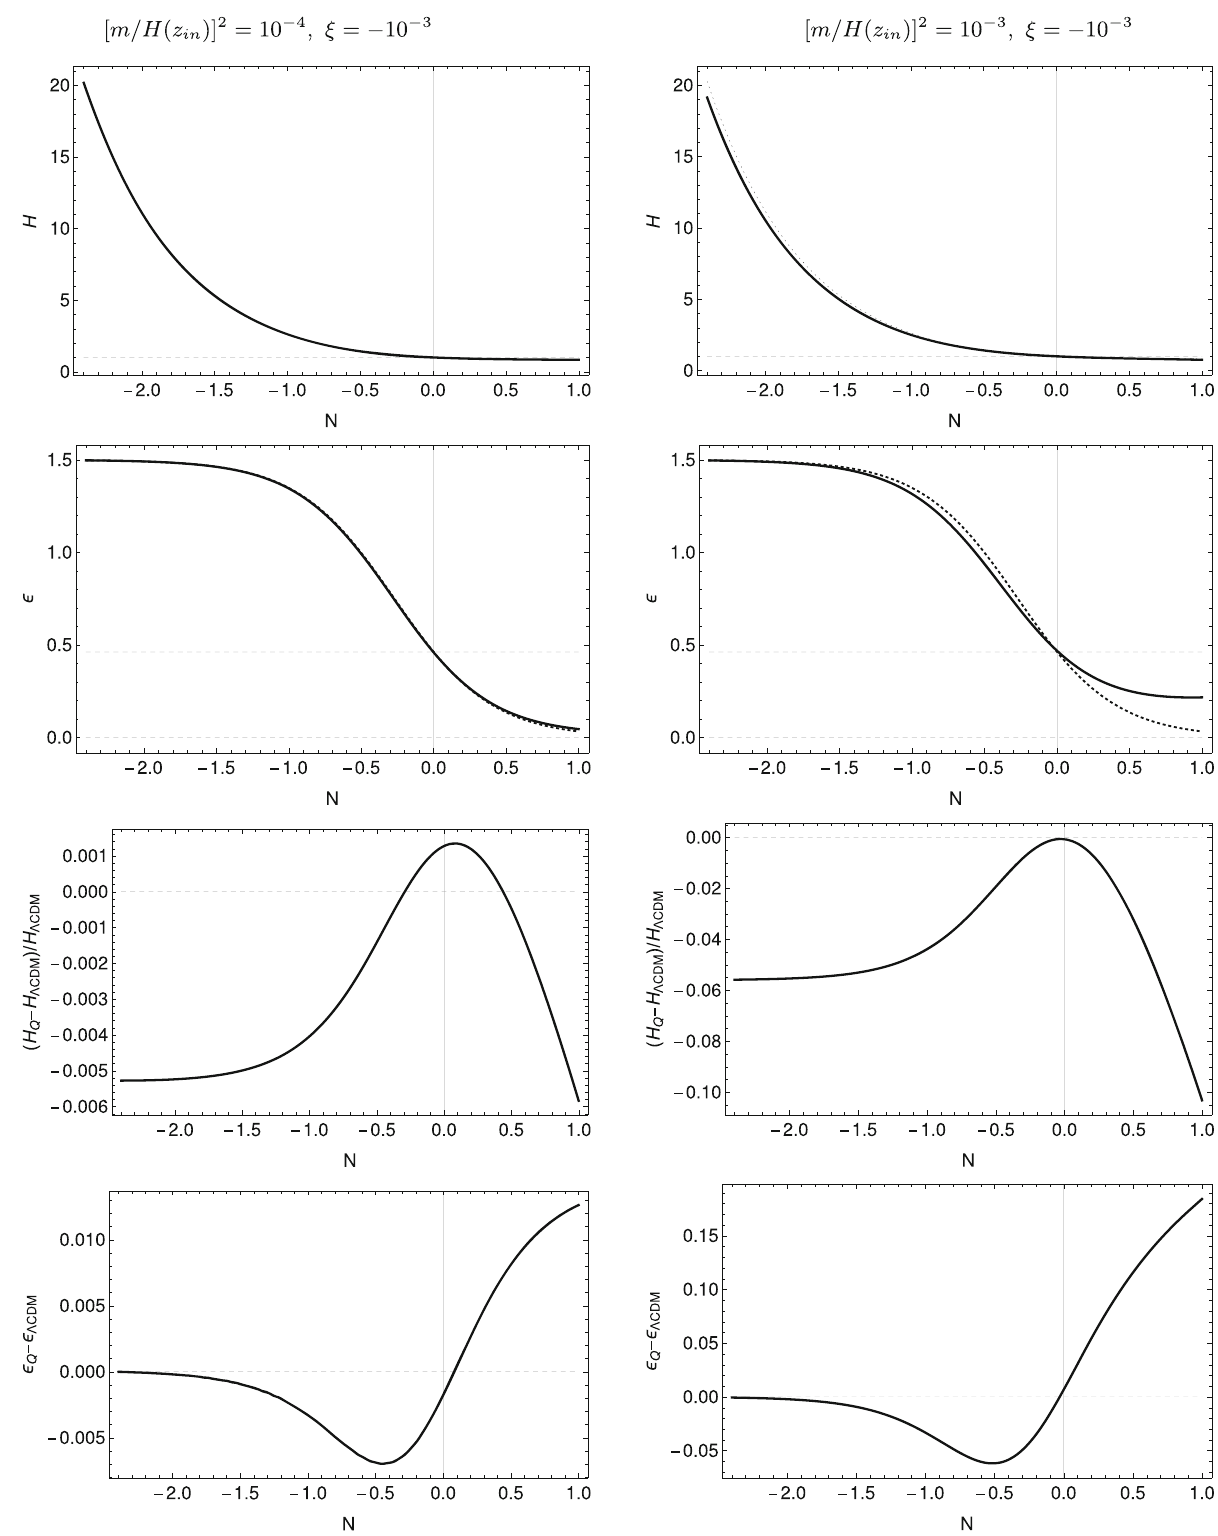
Fig. 3 Quantum backreaction model versus the Λ CDM model. Two columnsrepresenttwodifferentchoicesofparameters ξ and m . Leftcol- umn [ m / H ( z in ) ] 2 = 10 − 4 , ξ = − 10 − 3 . Right column [ m / H ( z in ) ] 2 = 10 − 3 , ξ =− 10 − 3 . The first row shows plots of the Hubble rate, and the